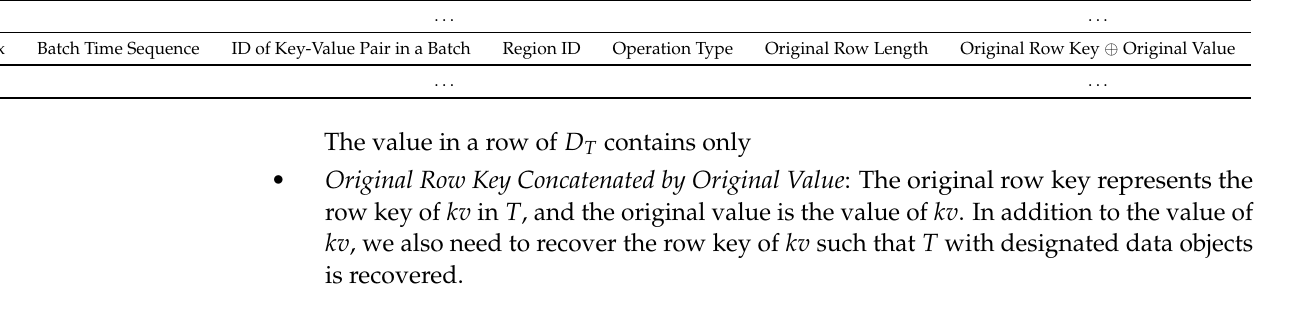
Table 1. Schema in a shadow table D T (Here, ⊕ denotes the string concatenation operator.) Row Key Value